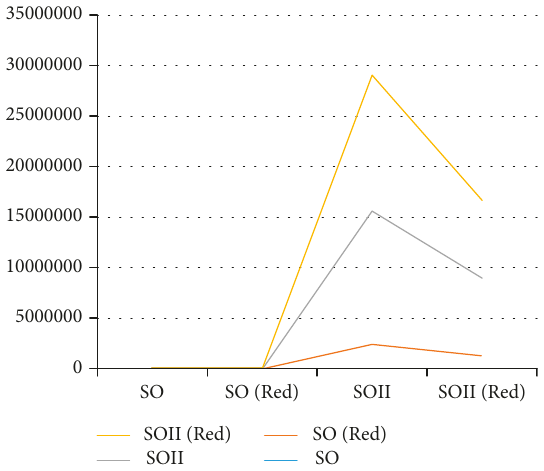
Figure 5: Graphical comparison of SO , SO